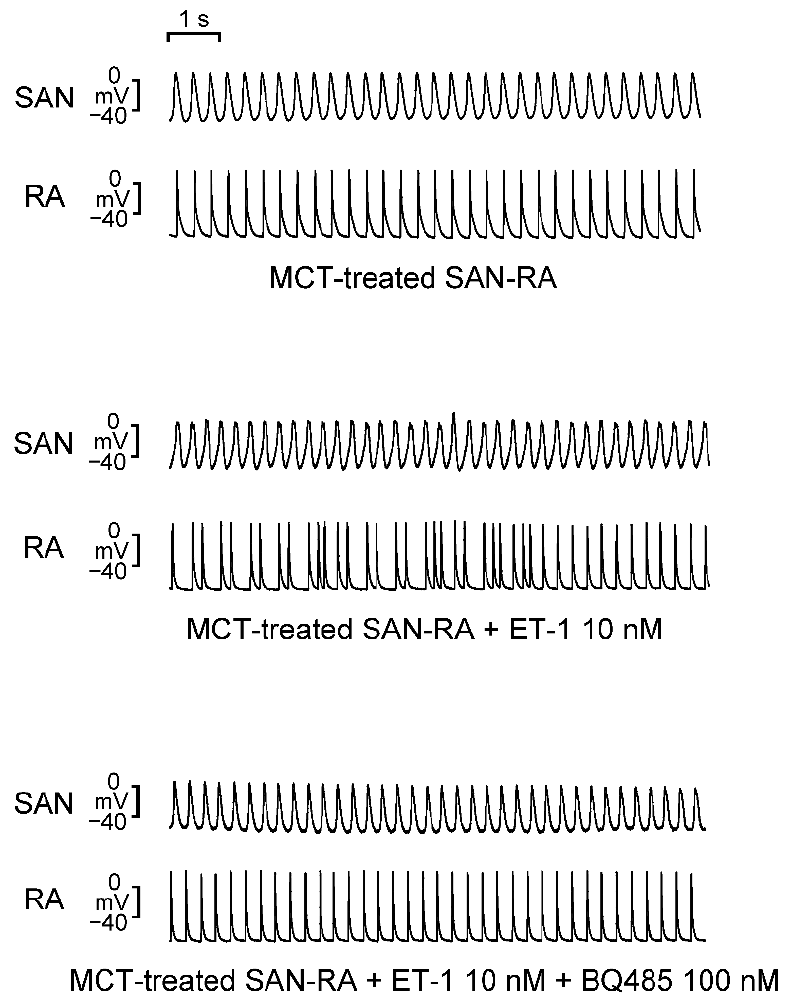
Figure 6. Effects of BQ 485 (an endothelin-A receptor antagonist) on the electrical activity of en- dothelin (ET)-1-treated sinoatrial node–right atrium (SAN–RA) preparations from monocrotaline (MCT)-treated rabbits. The representative tracings demonstrate the electrical activity of MCT-treated SAN–RA preparations after ET-1 (10 nM) and BQ 485 (100 nM) administration.